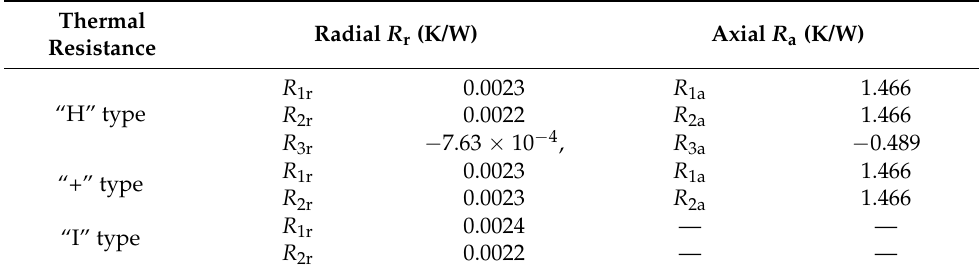
Table 4. Thermal resistance results with three